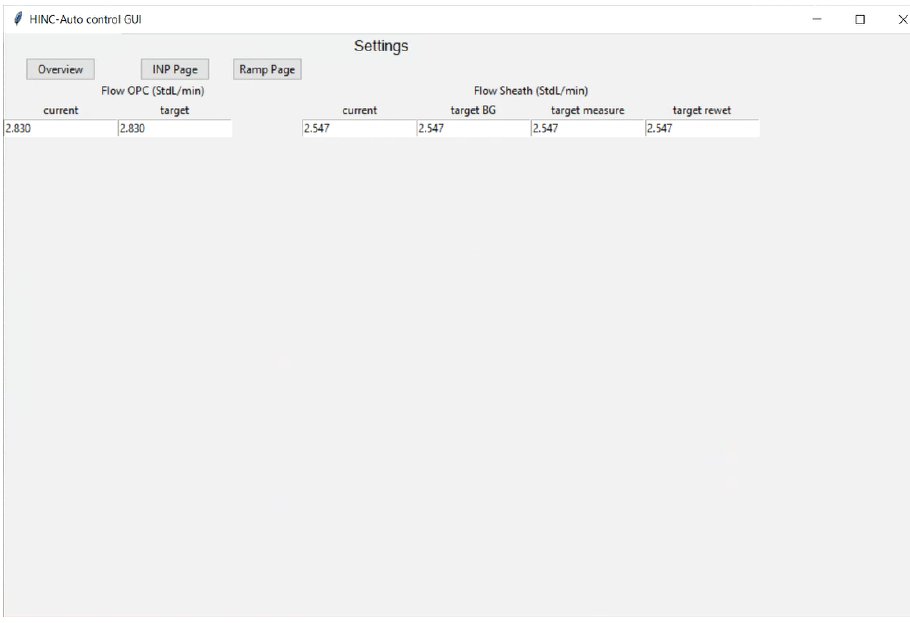
Figure A11. Window of the guided user interface used to adjust additional settings with